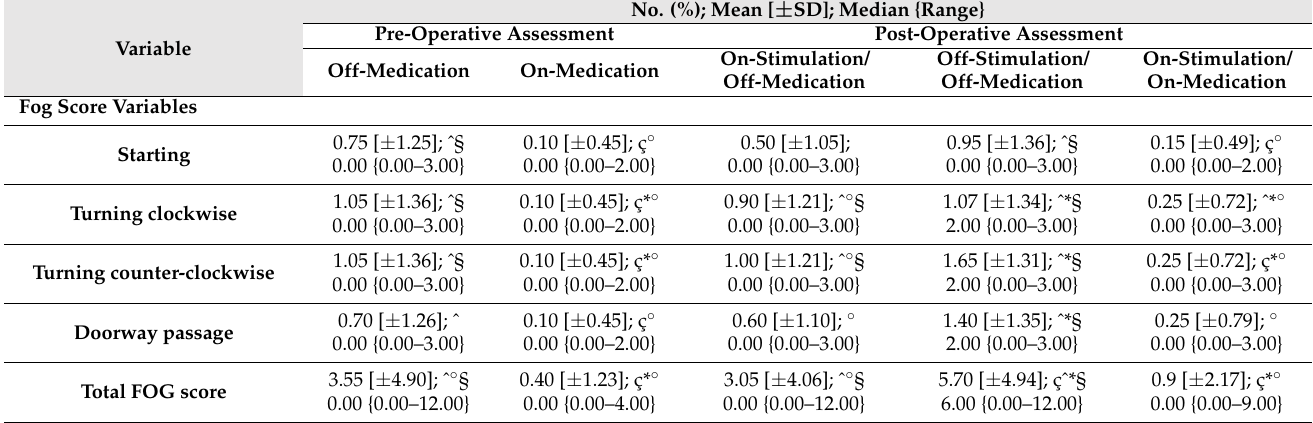
Table A4. Changes of FOG over